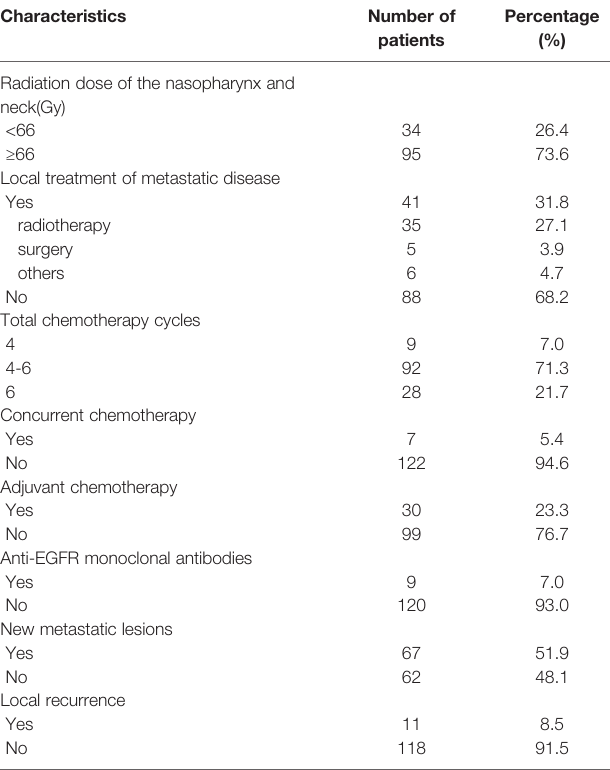
TABLE 2 | Treatment characteristics.